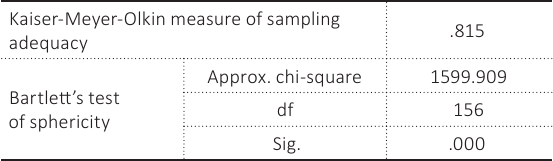
Table 4. KMO and Bartlett’s Test